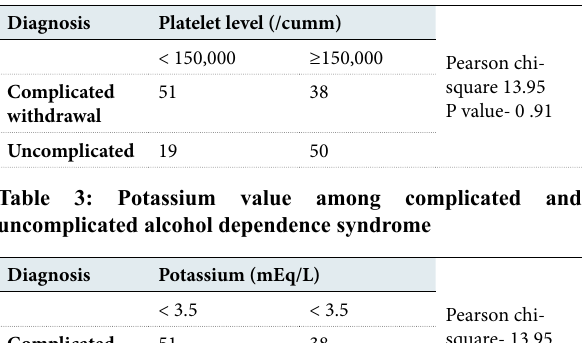
Pearson chi- square- 13.95 P value- 0